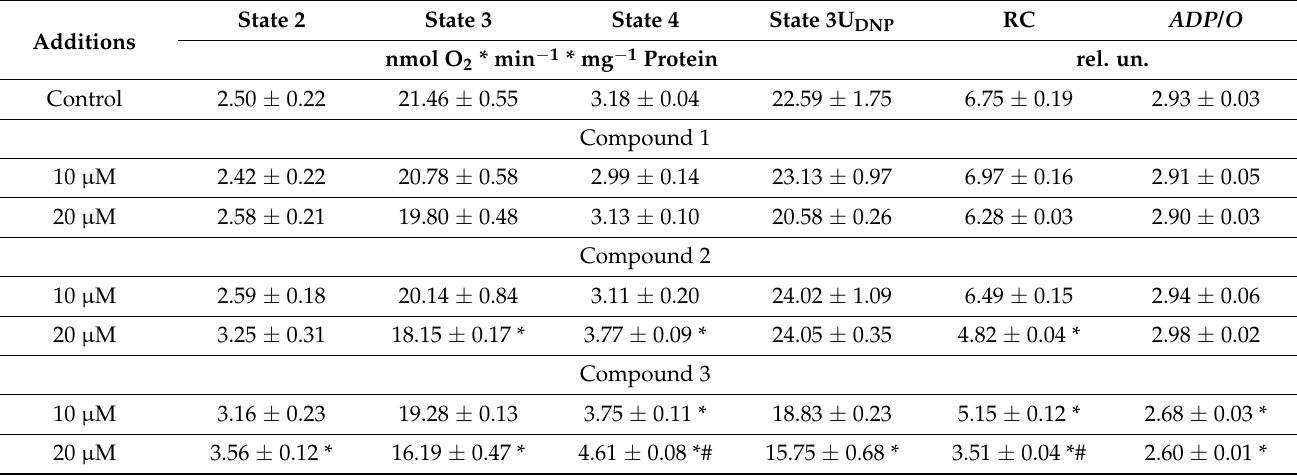
Table 1. Effects of modified levopimaric acid diene adducts on the respiration of rat liver mitochondria fueled by glutamate and